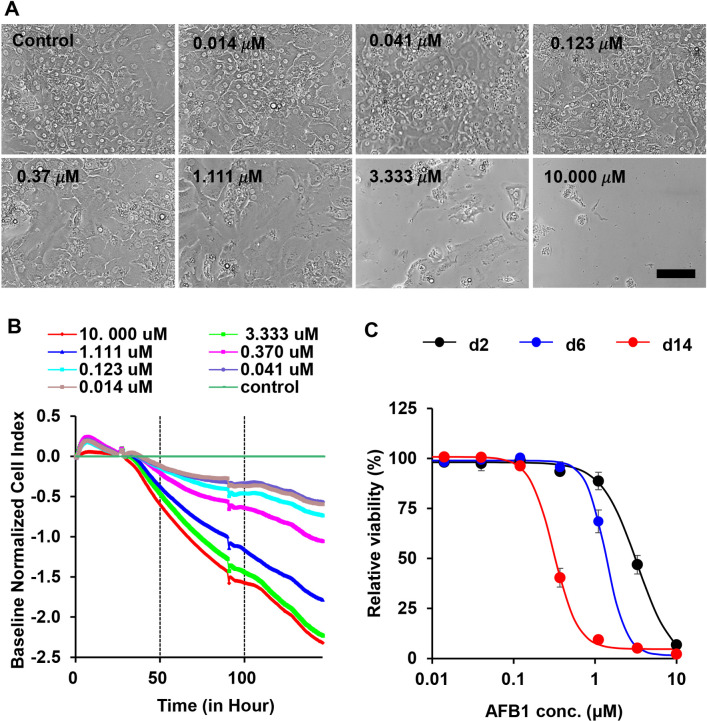
Dose-dependent cytotoxicity of AFB1 on PXB-cells.(A) Representative images of PXB-cells treated with AFB1 indicated concentrations for 5 days. Scale bar; 100 μm. (B) Cytotoxicity curves of PXB-cells exposed to AFB1 at different doses for 150 h. Cell index curves were generated with the iCELLigence software. (C) Dose-response curves of PXB-cells exposed to AFB1 for 2, 6, and 14 days. Cell viabilities were measured with the WST-1 assay.